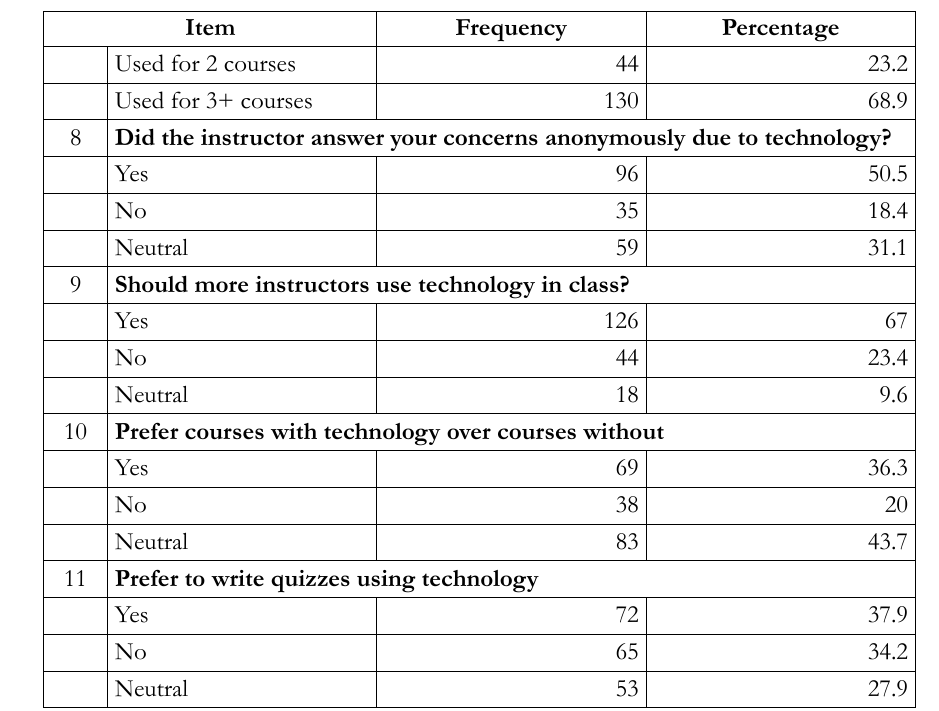
Table 1. Frequency analysis for each item in the